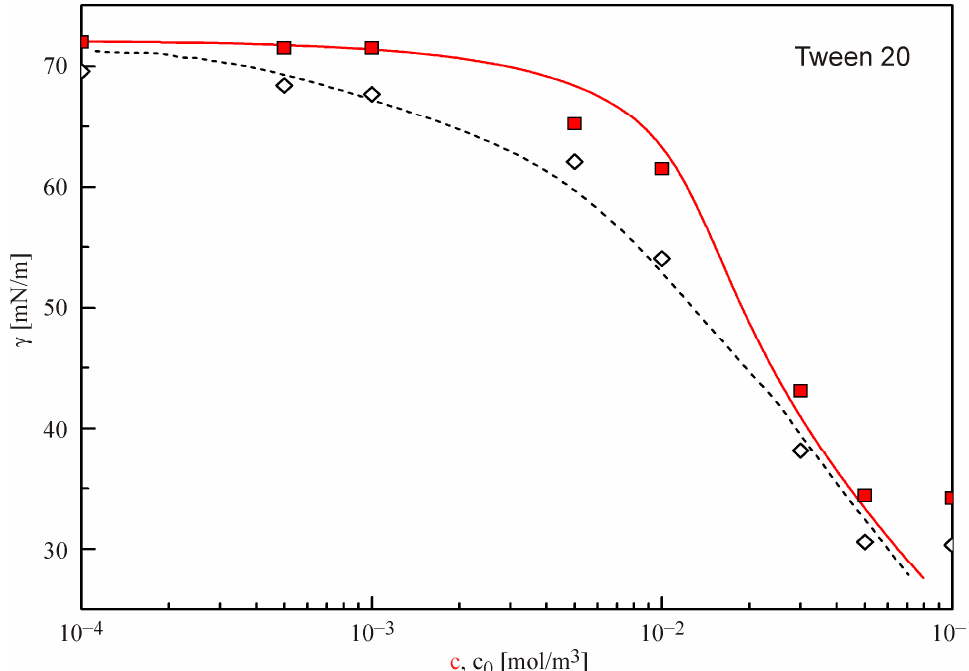
Figure 4. Equilibrium surface tension isotherms for aqueous Tween 20 solutions, as measured by bubble profile ( ) and drop profile analysis tensiometry ( ); lines represent the fitting results as explained in the text.